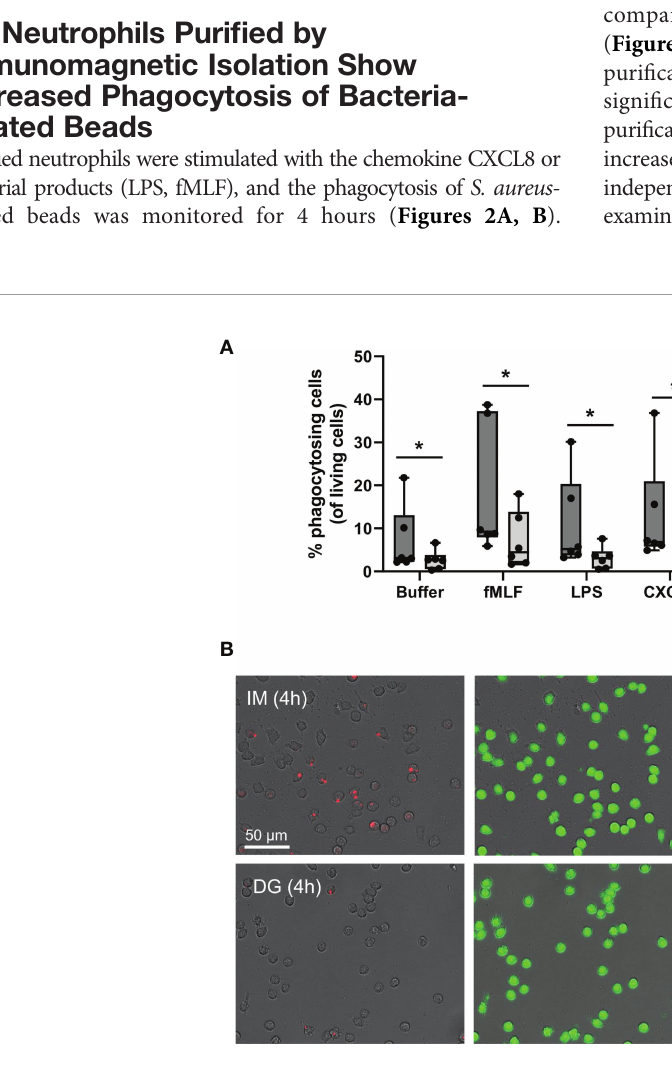
FIGURE 2 | Neutrophils puri fi ed by immunomagnetic isolation show increased phagocytosis of bacteria-coated beads. Peripheral blood neutrophils were isolated by immunomagnetic (IM) or density-gradient (DG) puri fi cation. The capacity of neutrophils to actively engulf extracellular particles was quanti fi ed using S. aureus -coated beads and imaged using the Incucyte S3 live cell imaging system. (A) Neutrophils were additionally stimulated with buffer, fMLF (10 -7 M), LPS (100 ng/ml) or CXCL8 (50 ng/ml). (B) Representative image of phagocytosed beads (red) and puri fi ed, living neutrophils (green) after 4 hours of stimulation with fMLF. Results are represented as the percentage phagocytosing neutrophils normalized to the amount of living cells. Data are shown as box-and-whisker plots (box: median with interquartile range, whiskers: full data distribution), with each dot representing an individual healthy donor (n = 6) and were statistically analyzed by Wilcoxon matched-pairs signed rank test (*p < 0.05 for statistical differences between neutrophils puri fi ed with immunomagnetic or density gradient